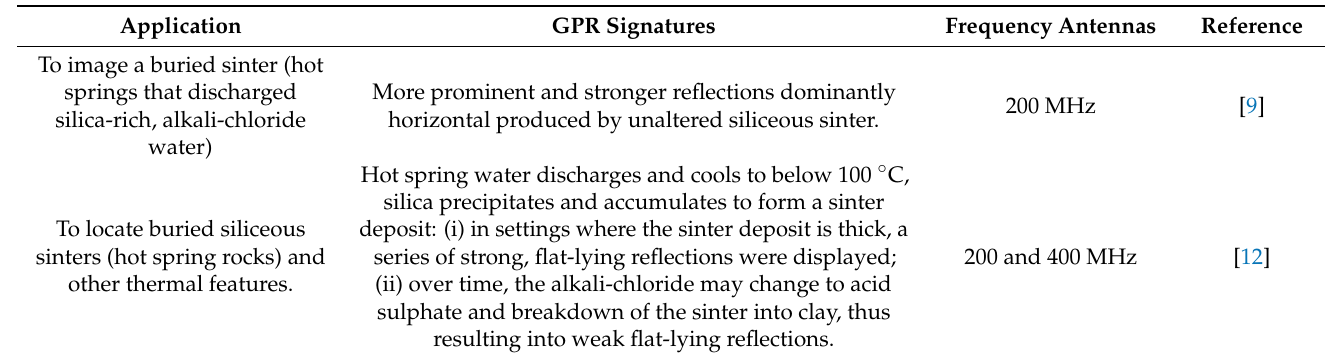
Table 1. GPR signatures generally associated with hot springs.